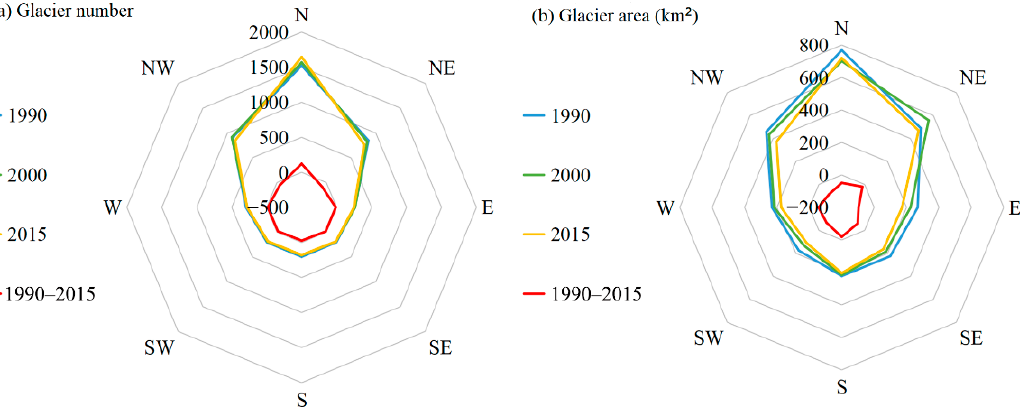
Figure 7. Distribution of glacier areas and their changes according to location in the northern Tien Shan from 1990 to 2015.